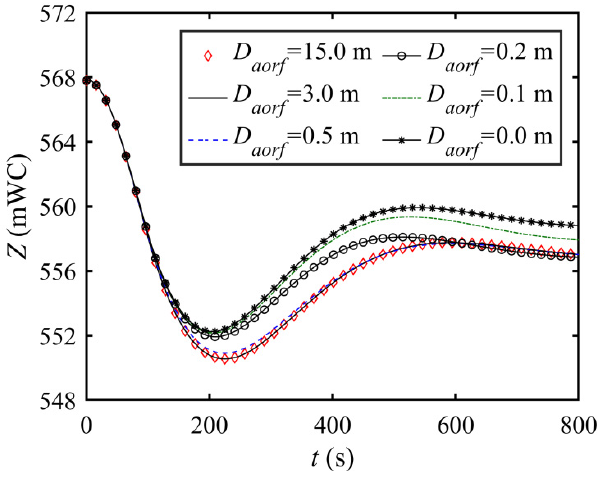
Figure 5. Load rejection—STWL for the semi-pneumatic throttled chamber surge tank for various aeration orifice diameters.